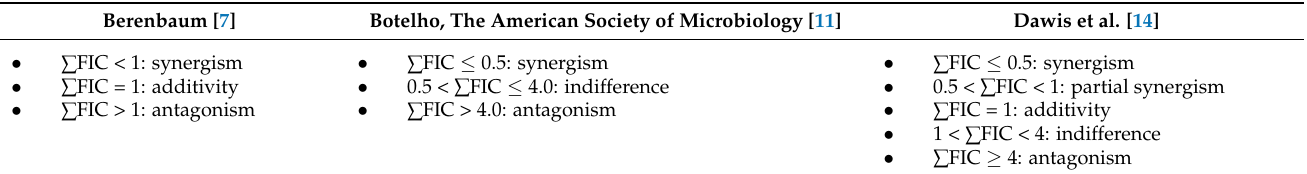
Table 1. Assessment of synergism, partial synergism, indifference, additivity, and antagonism based on the ∑ FIC *-Index by different